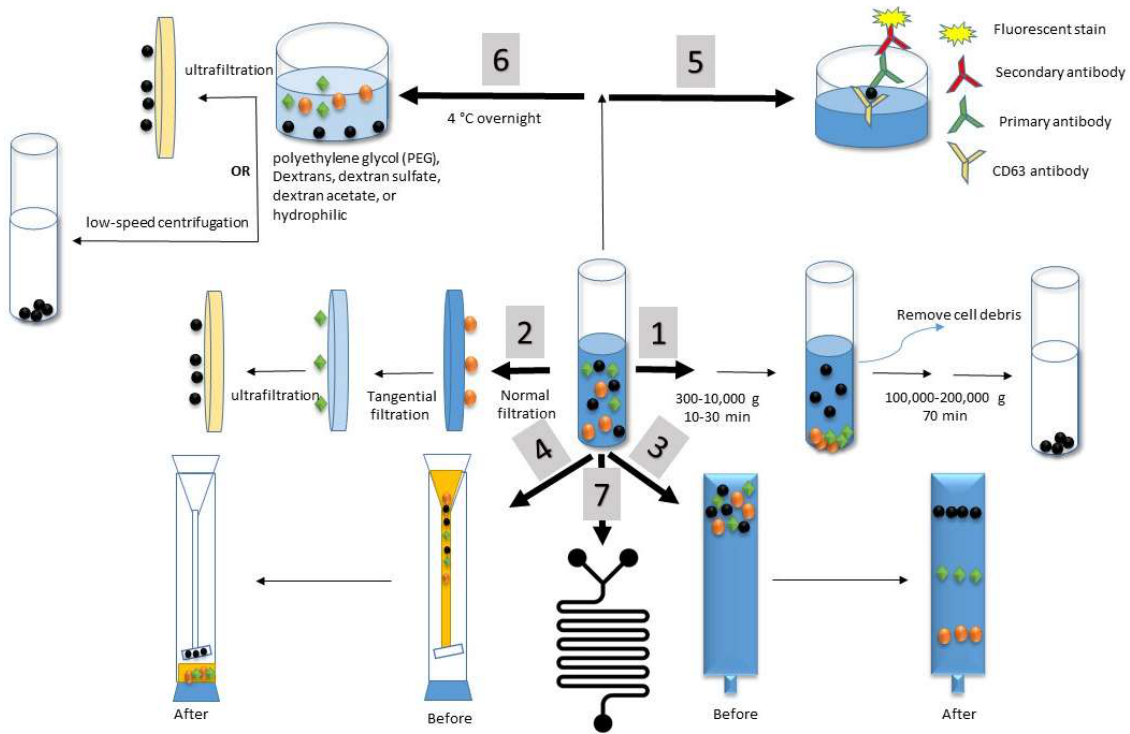
Figure 4. Isolation techniques for exosomes. The exosomes are represented by the small, black balls. The techniques are represented as separated pathways as follows: (1) ultracentrifugation, (2) ultrafiltration, (3) size exclusion chromatography, (4) hydrostatic filtration dialysis, (5) immunoaffinity, (6) precipitation, and (7) microfluidics.